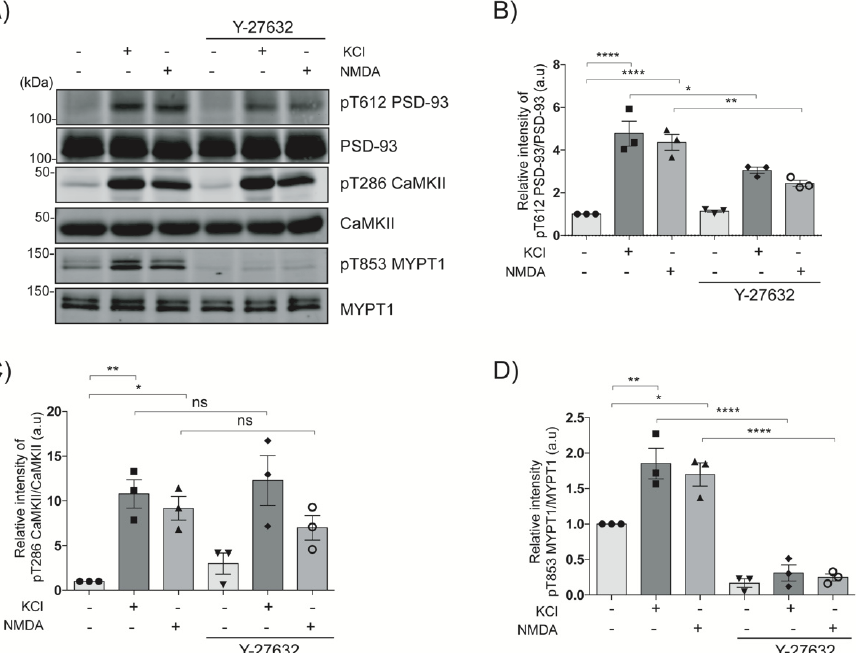
Figure 3. Rho-kinase phosphorylates PSD-93 at Thr612 in striatal slices downstream of NMDARs. ( A ) Striatal slices were treated with or without the Rho-kinase inhibitor Y-27632 (20 µ M for 60